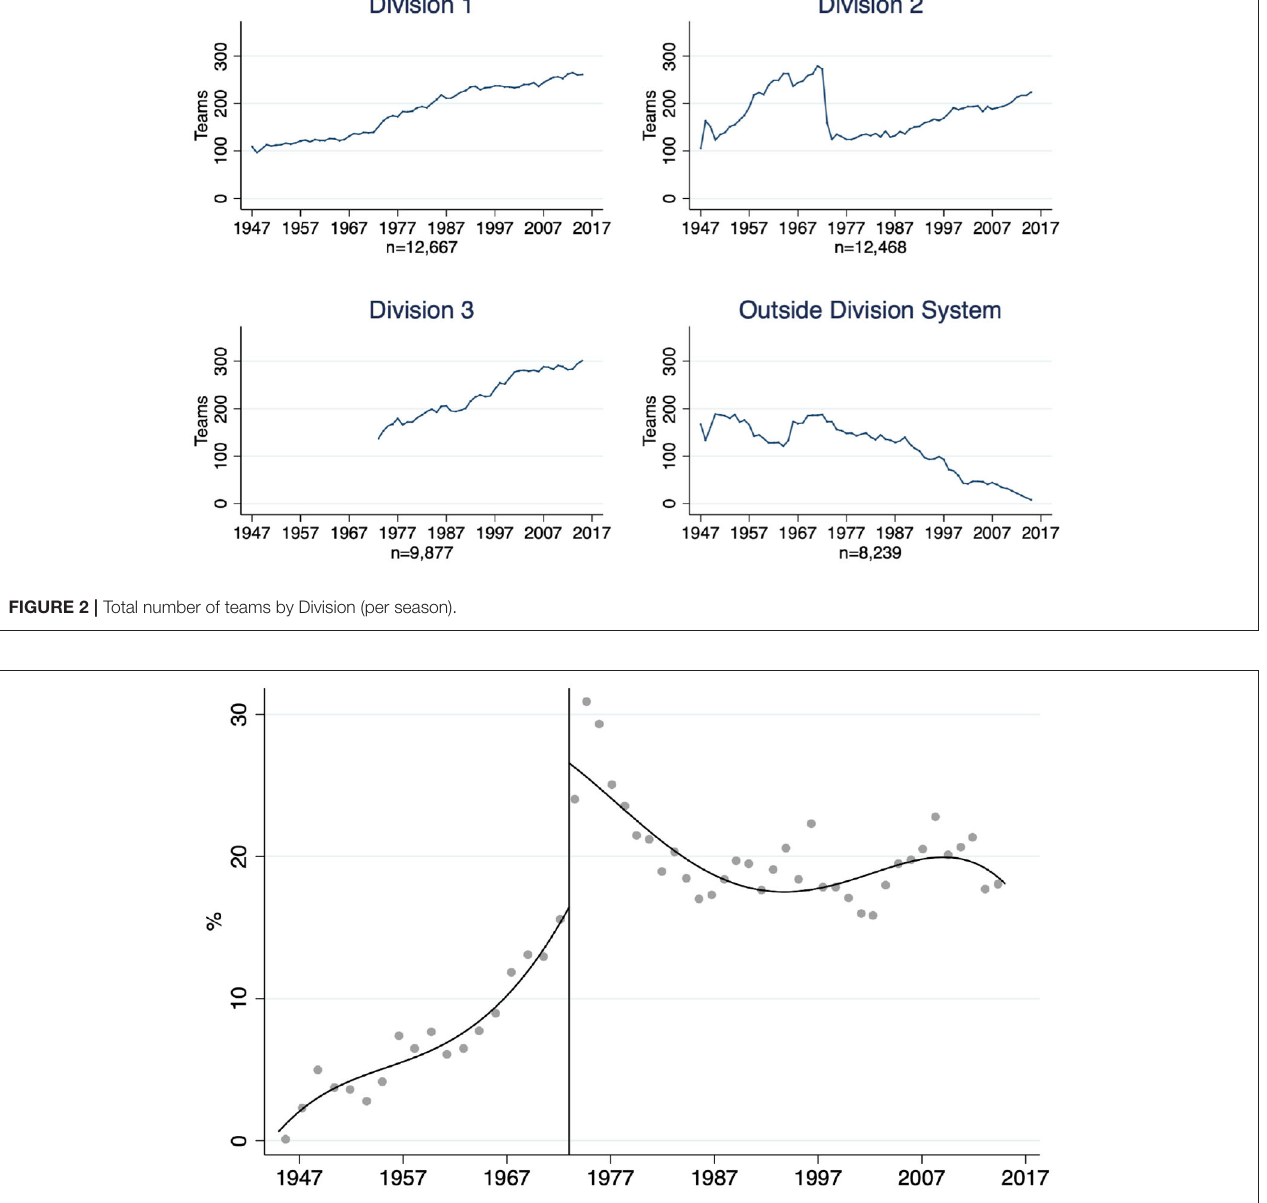
FIGURE 3 | Black coaches in division